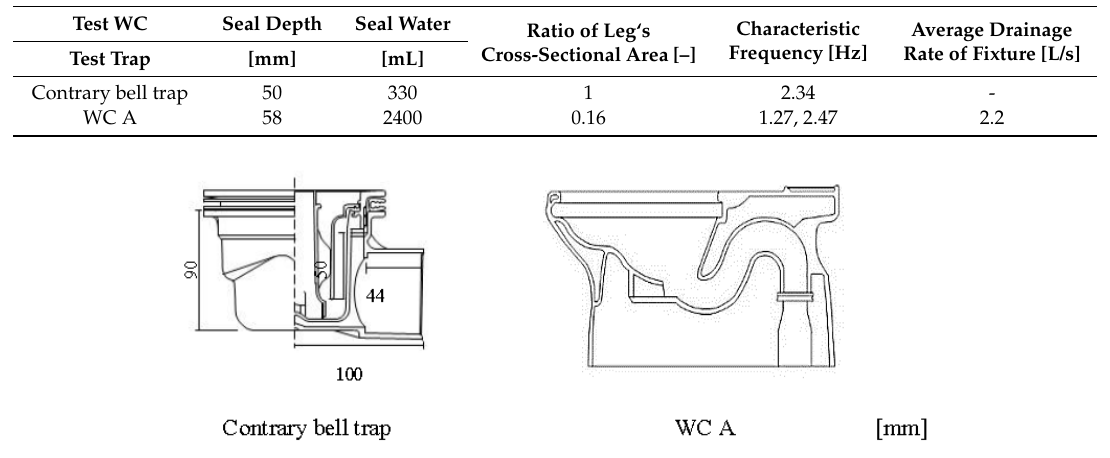
Figure 2. Cross-sectional views of a test trap and a test WC A.